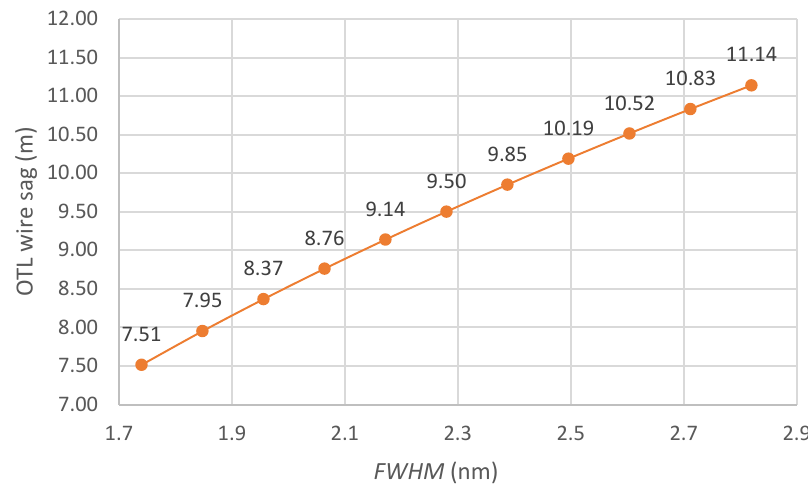
Figure 11. The dependency of the OTL wire sag as a function of the measured FWHM.